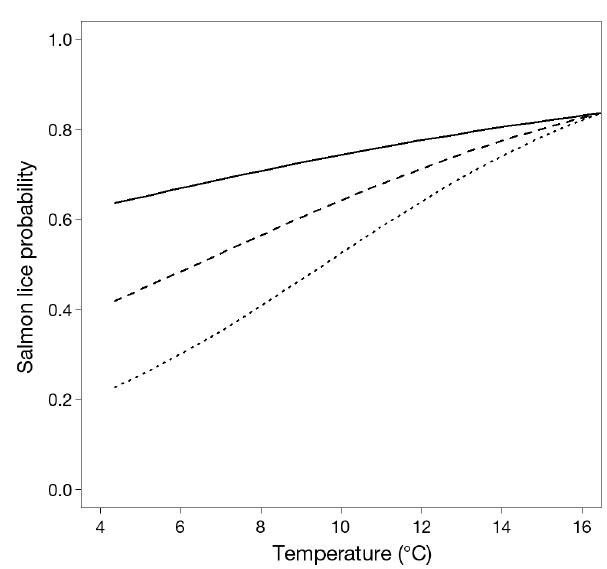
Fig. 4. Predicted probability of a wild sea trout Salmo trutta having salmon lice Lepeophtheirus salmonis as a function of the interaction between infestation pressure from farms and temperature (parameter values from the regression are presented in Table 1). Solid line, long dashed line and short dashed line represent infestation pressure with levels 3, 2 and 1, respectively. Higher levels of infestation pressures are not plotted, since the majority of the data (94%) were below this level (see Fig. 3)